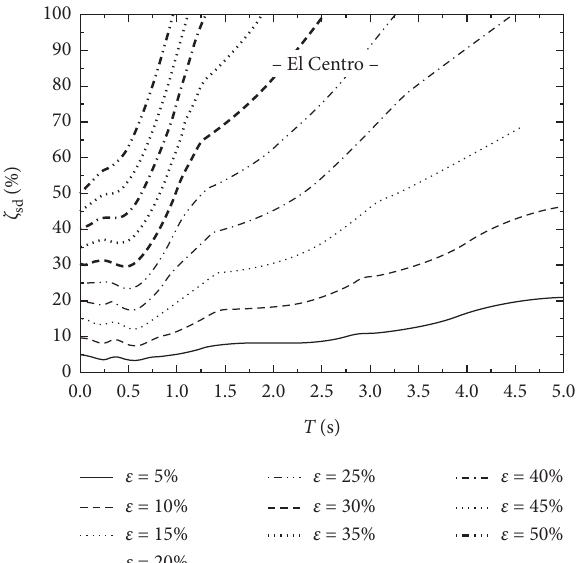
Figure 2: ADR spectra for different values of ε under the excitation of the north-south component of El Centro ground motion ( α � 0.50).